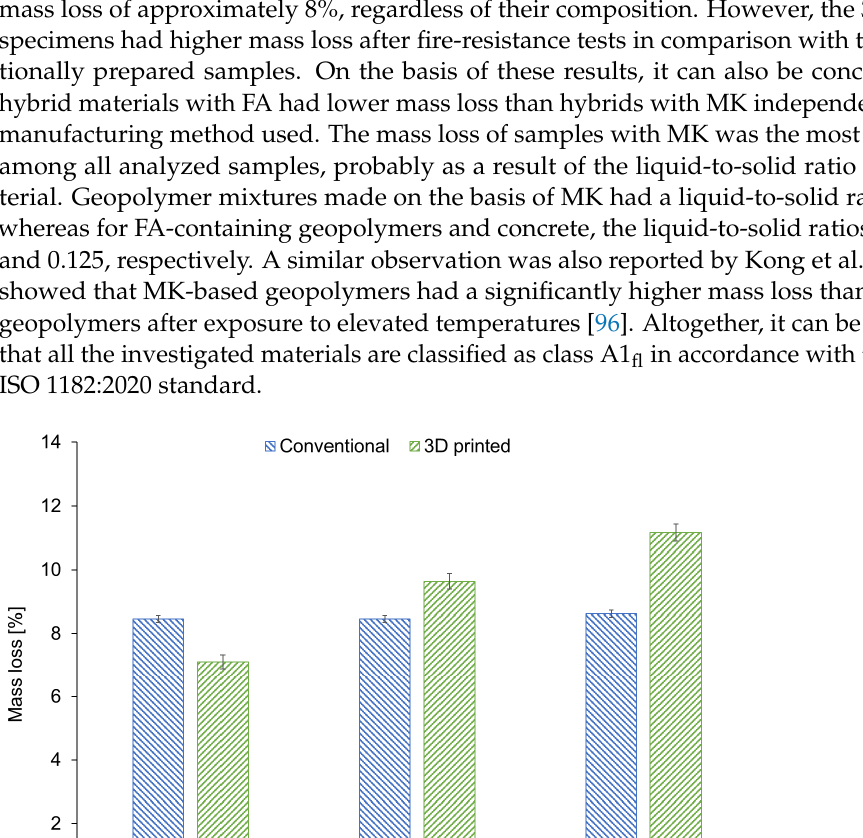
Table 5. The surface of the samples after the fire resistance test, depending on the method of their production (mold casting and 3D printing) and the composition of the mixture (100% C, 95% C + 5% FA, 95% C + 5% MK). The arrows indicate the cracks on the surface of the samples developed after fire resistance tests.